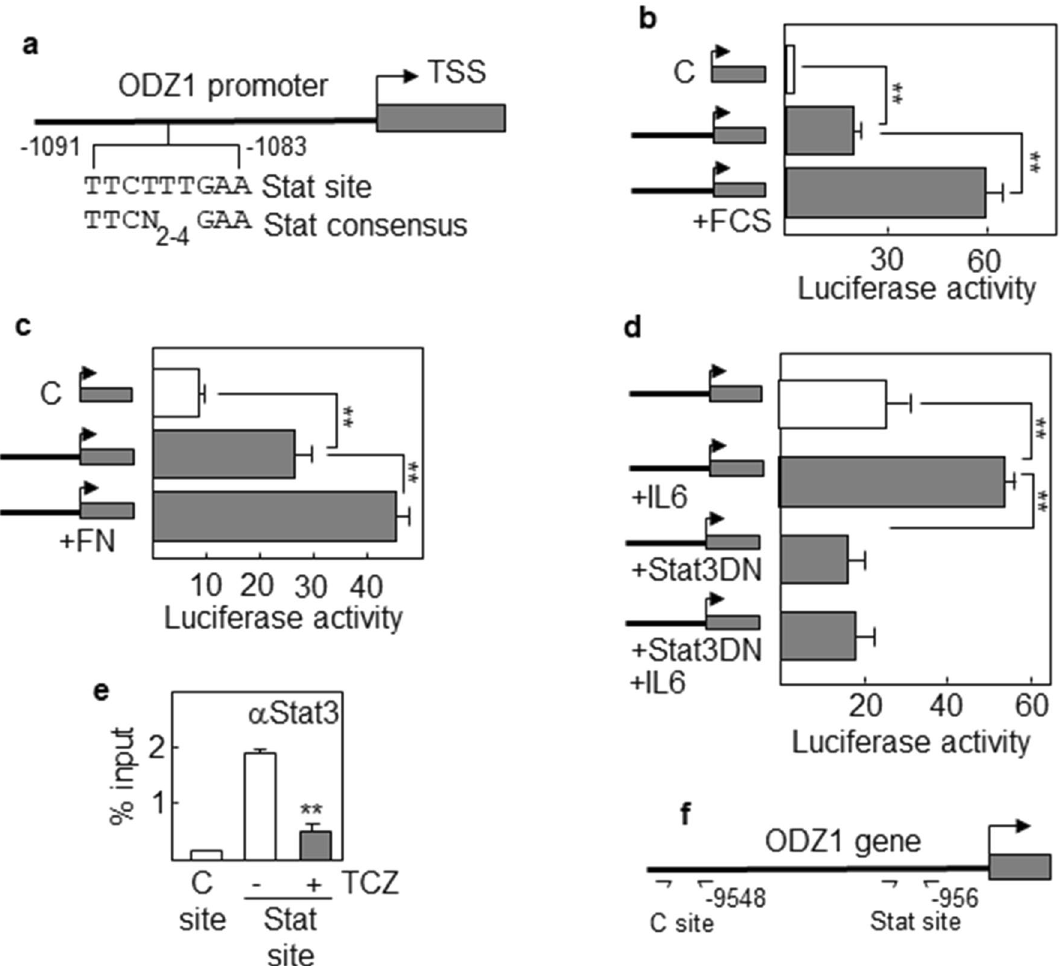
Figure 5. ODZ1 promoter responds to Stat3-activating stimuli. ( a ) Schematic representation of ODZ1 promoter, indicating the position and sequence of the Stat site relative to the transcription start site (TSS). Stat consensus sequence is included for comparison. GBM1 cells transfected with an ODZ1 promoter- luciferase reporter construct were incubated with FCS ( b ) or cultured onto fibronectin-coated surface ( c ) and luciferase activity was used as an indicator of promoter activity in response to the stimuli. ( d ) GBM1 cells were cotransfected with the reporter construct and a dominant negative variant of Stat3 and the response of ODZ1 promoter to IL-6 was determined by analyzing luciferase activity. ( e ) Chromatin immunoprecipitation assay using GBM cells incubated in the presence of IL-6 with or without Tocilizumab. Immunoprecipitated DNA was analyzed by qPCR with primers flanking the Stat site in the ODZ1 promoter or an irrelevant control site further upstream. ( f ) Schematic representation of the ODZ1 gene showing target sites for ChIP assay. Histograms represent the mean of three independent experiments ± S.D. **p <